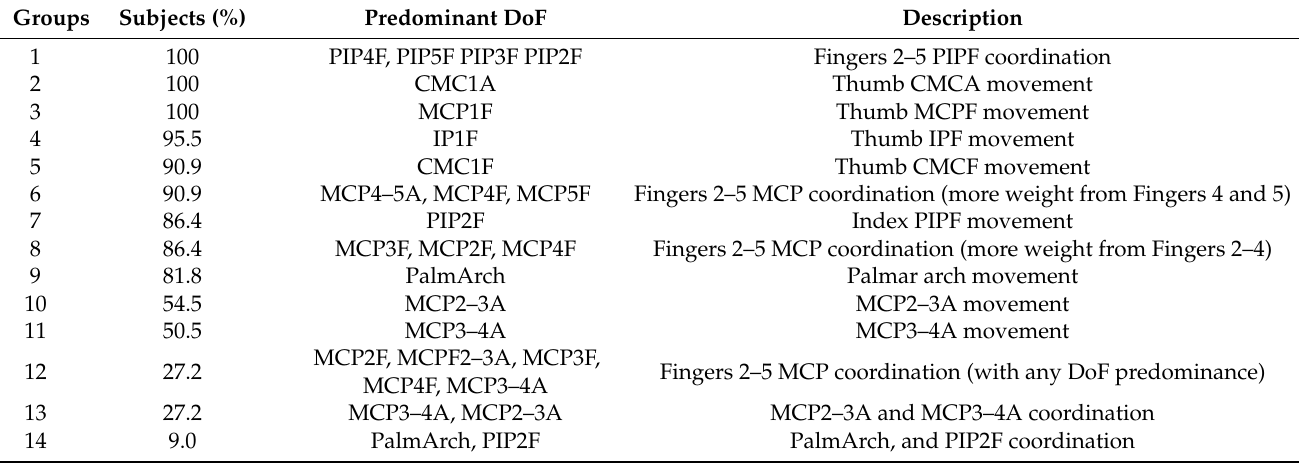
Table 1. Percentage of subjects, predominant degrees of freedom (DoF) (sorted from higher to lower correlation coefficients) and description of each group of synergies. F for flexion/extension and A for abduction/adduction movements. 1 to 5 for thumb to little digits.